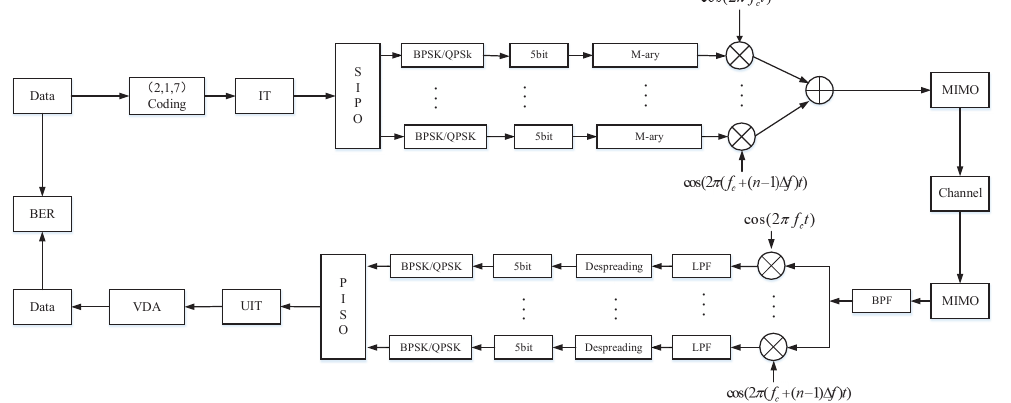
Figure 11. Mary-MCM scheme overall flow